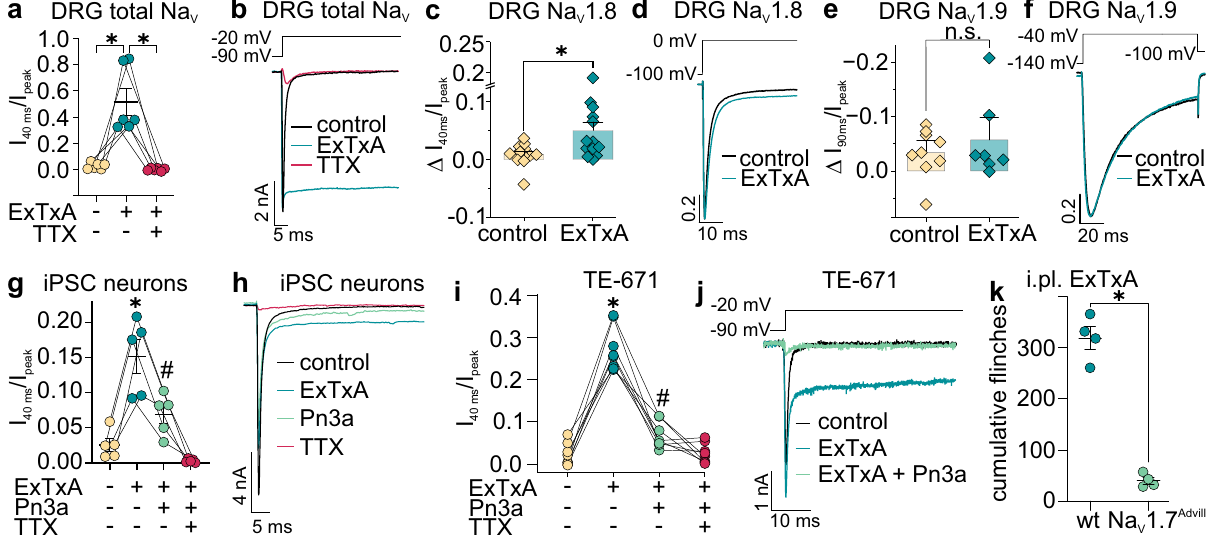
normalized Na V 1.9 currents of buffer control (0.1% BSA) and ExTxA (1 μ M)-treated